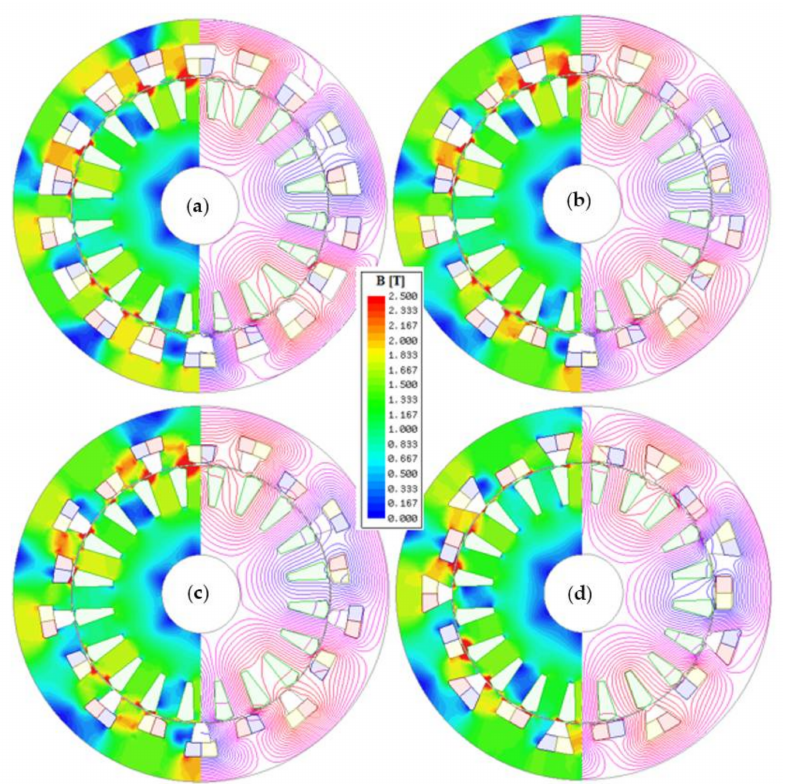
Figure 12. Flux density and line distributions of the AIMs. ( a ) 1. Step; ( b ) 2. Step; ( c ) 3. Step; ( d ) final configuration.